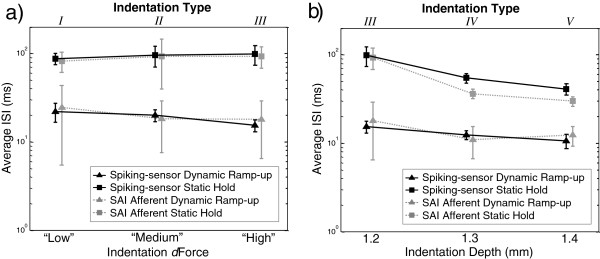
AverageISIcompared between spiking-sensor model and SAI afferent spike times. Across a) increasing indentation ramp-up dForce and b) increasing indentation depth, average ISI (error bars = SD) is compared between spiking-sensor model and SAI afferent spike times for dynamic ramp-up and static hold phases. Note log scale used on y-axes.